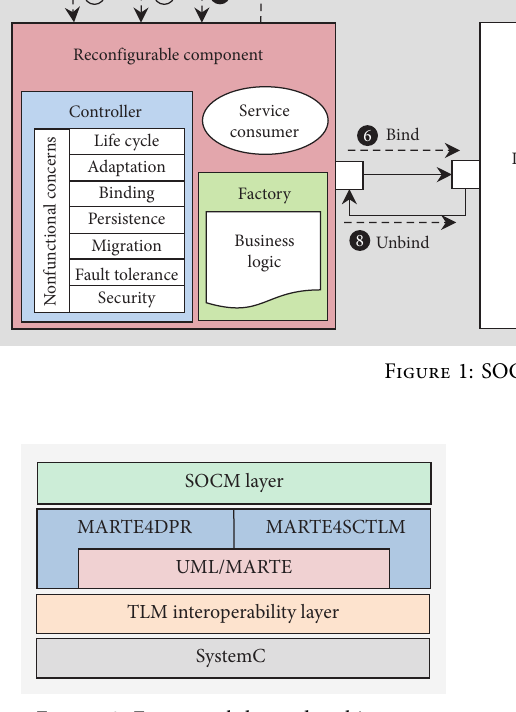
Figure 2: Framework layered